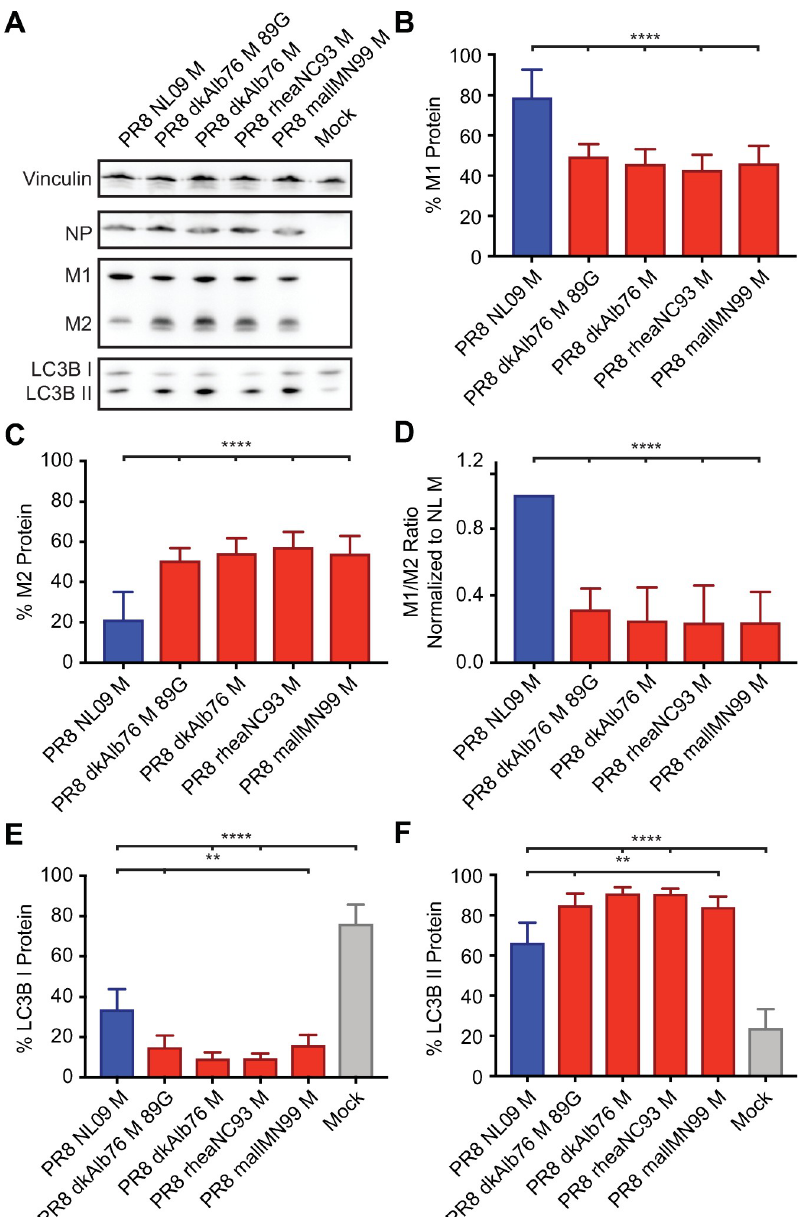
Fig 5. High expression ratio of M1 to M2 protein in A549 cells is dependent upon viral M segment host origin. A549 cells were inoculated at a MOI of 5 PFU/cell with PR8 viruses encoding avian or human-derived M segments and incubated at 37˚C for 8 h, then lysed. Western immunoblot analysis of virus-infected A549 cells: (A) Vinculin expression was measured to allow normalization of viral protein levels. NP expression was measured to assess viral replication. Levels of M1 and M2 protein expression were assessed using an antibody (Mab E10) to a common epitope at the amino terminus of M1 and M2 proteins, allowing relative expression to be assessed. Levels of LC3B I and II were assessed using an antibody that detects both the precursor and activated forms of LC3B protein. (B) M1 protein and (C) M2 protein were normalized to vinculin, quantitated and displayed as a percentage of total protein expressed from the M gene. (D) The ratio of M1:M2 protein expression. (E) LC3B I protein and (F) LC3B II protein were normalized, quantitated and displayed as a percentage of total LC3B protein. Graphs in B-F show the means with SD from three independent experiments. For each experiment, two replicate Western immunoblots were performed and quantitated. Statistical significance was assessed using ordinary one-way ANOVA.